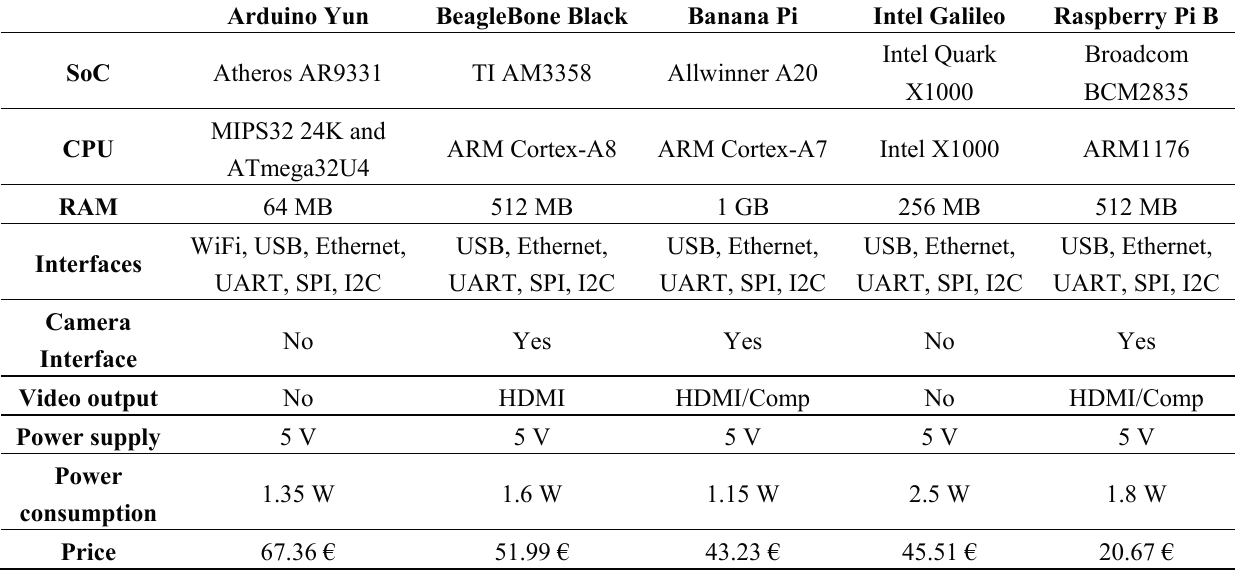
Table 4. Comparison between some Linux platforms. Prices were obtained from an international electronic distributor while the power consumptions of each device are obtained from the respective manufacturers’ web